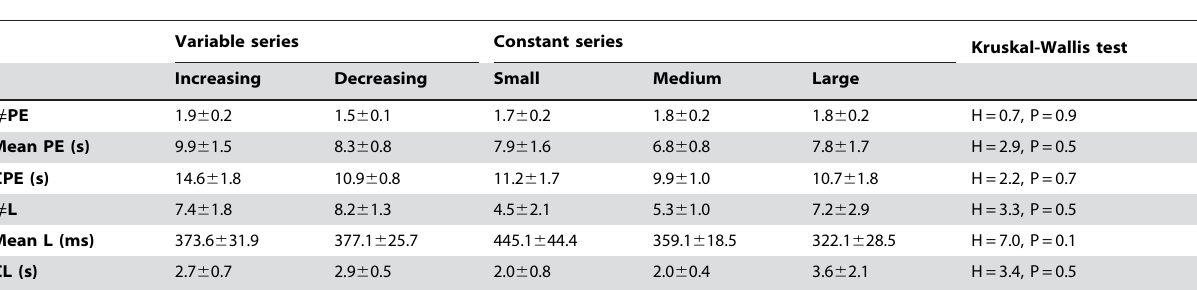
Table 1. Mean values ( 6 s.e.m.) of variables characterizing a PER’s strength.